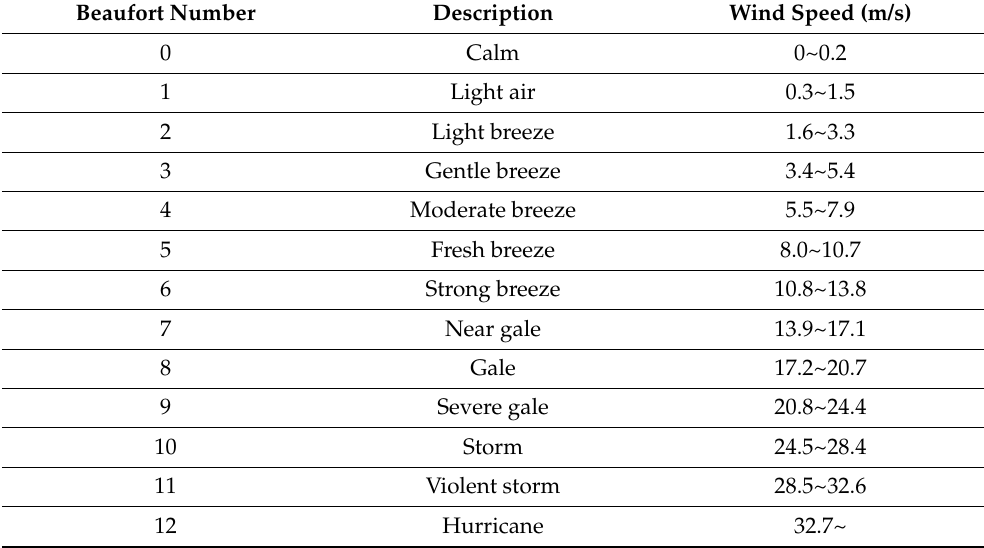
Figure 12. Buildings with a set-back structure shape on the south side of the LCT residential complex. Table 3. Beaufort Wind